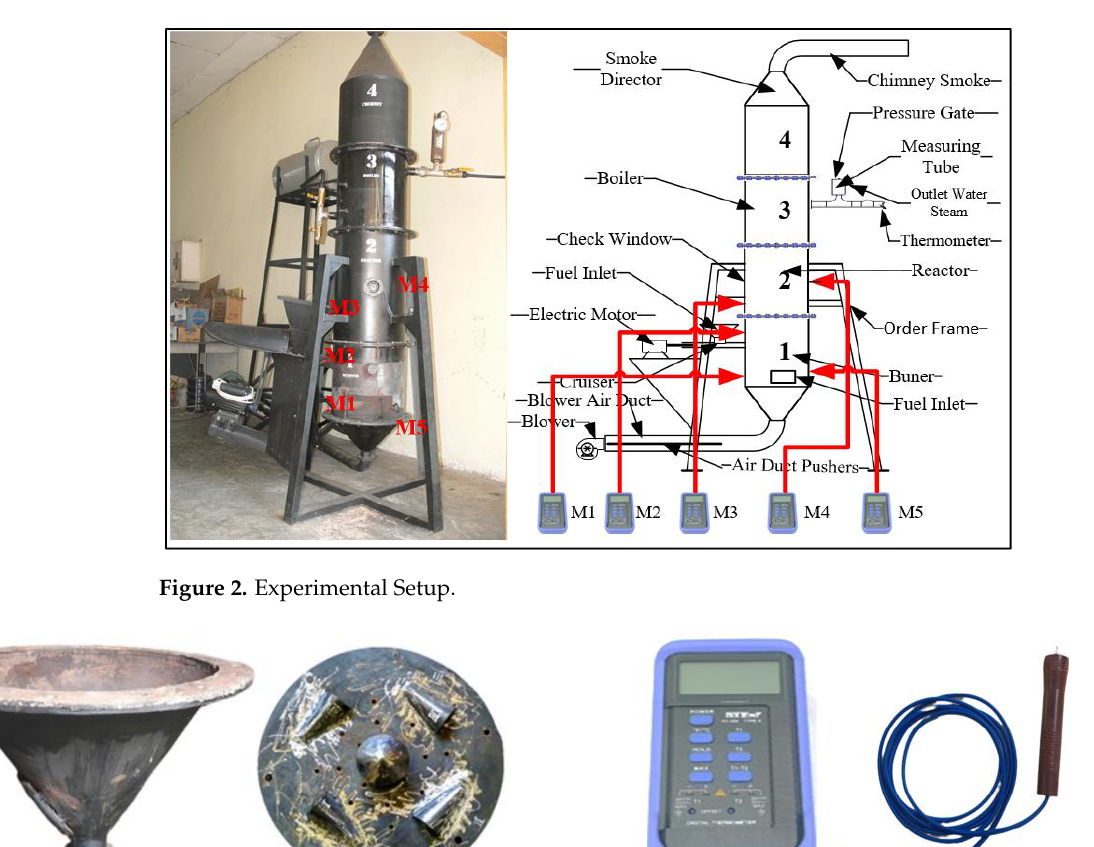
Figure 2. Experimental Setup.